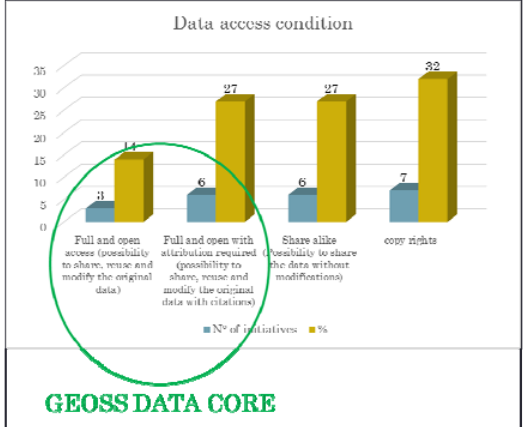
Figure 4. Geospatial resources that present the potential to be tagged GEOSS Data Core are made available by 15 initiatives